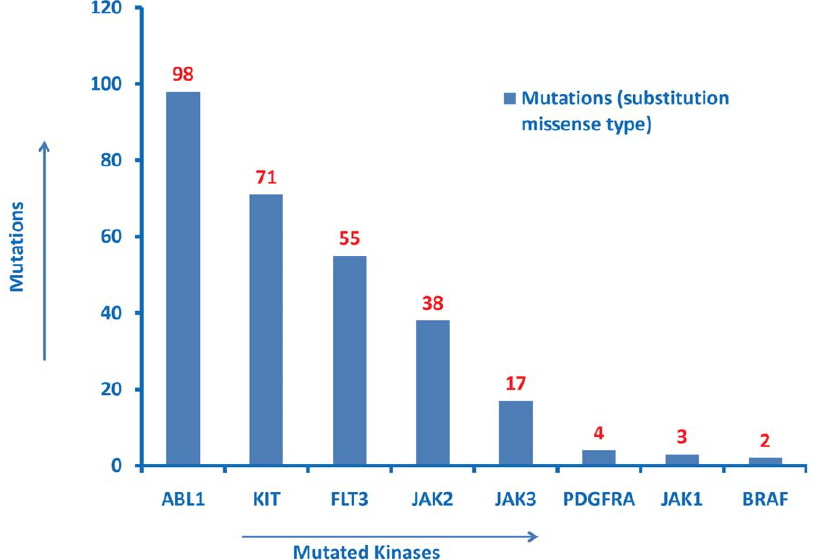
Figure 7. Counts of protein kinases having missense mutations implicated in haematopoietic neoplasm. Top 10 hits in descending order of the counts are displayed. The SPARQL query to generate this figure can be viewed and excuted from the ProKinO browser by selecting ‘‘Query 6’’ under the ‘‘Example queries’’ tab in the main page.